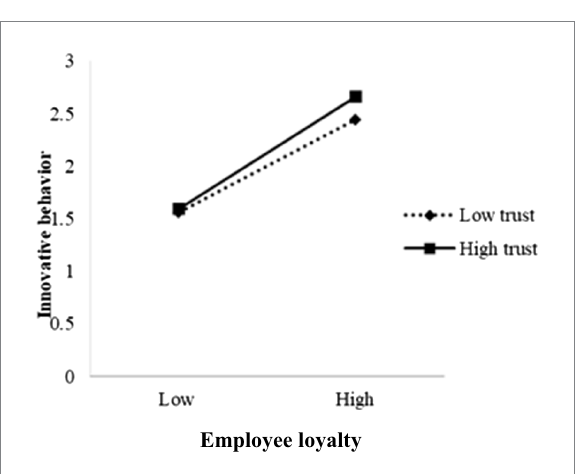
FIGURE 3 The interaction between employee loyalty and organizational trust on employee innovative behavior.